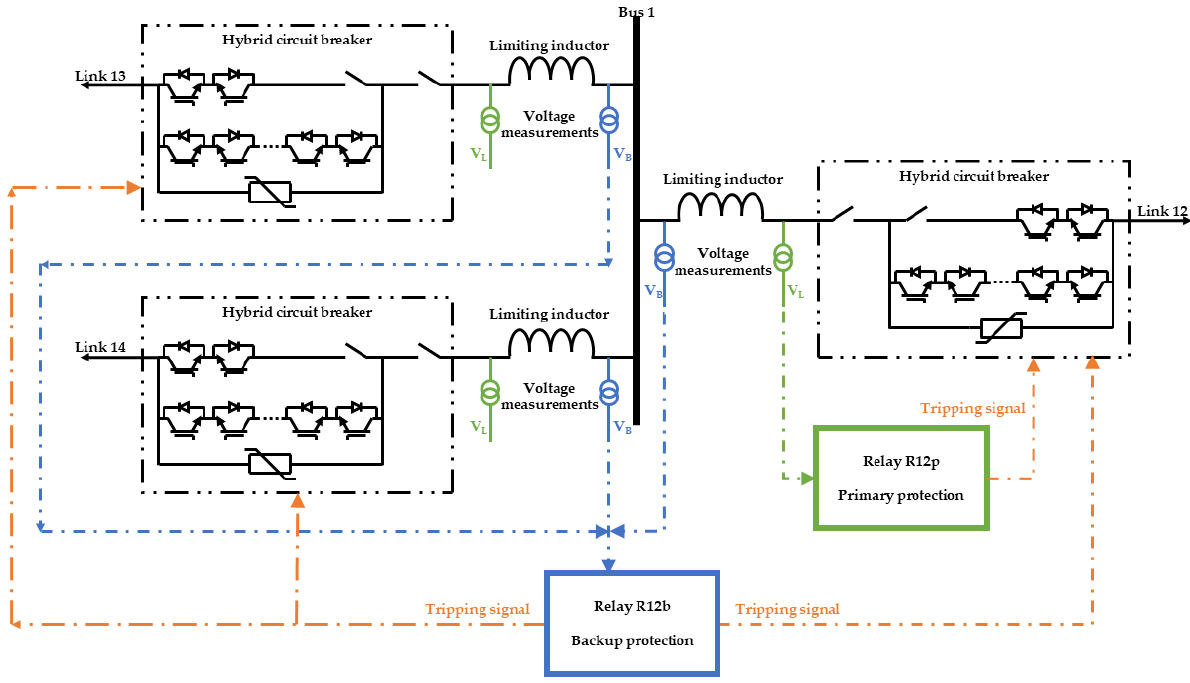
Figure 5. Diagram of the proposed protection scheme for Bus 1 and relay R12, only positive poles are represented.